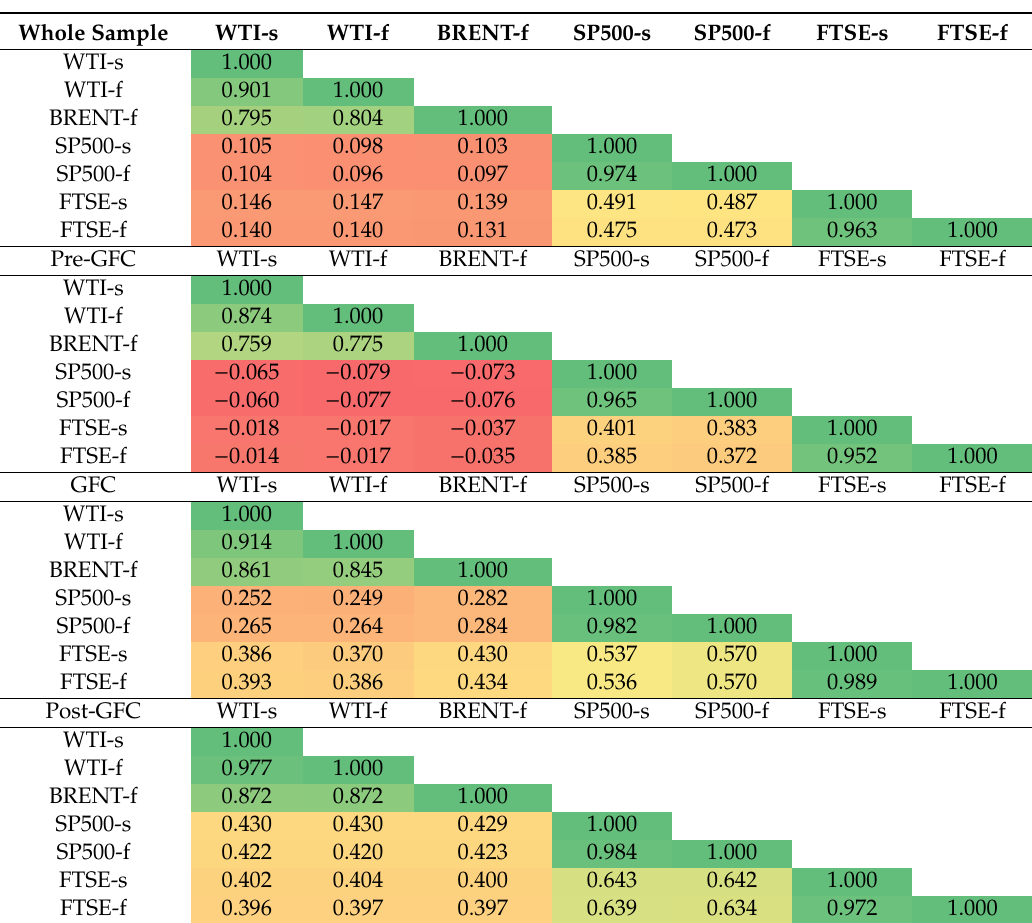
Table 3. Correlations of crude oil and financial markets in the UK and the